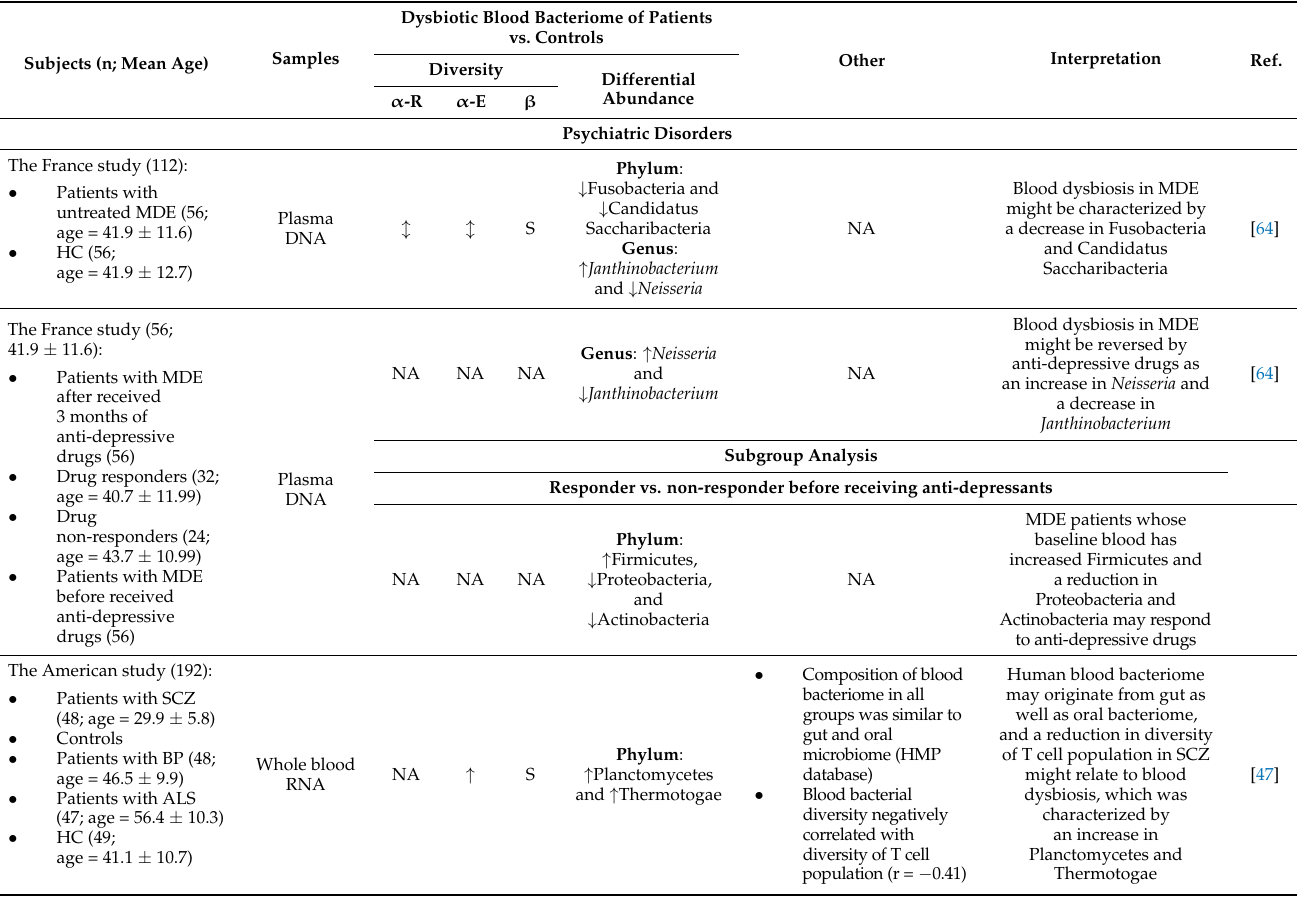
Table 5. Blood Bacteriome Dysbiosis Profiles in Neurological